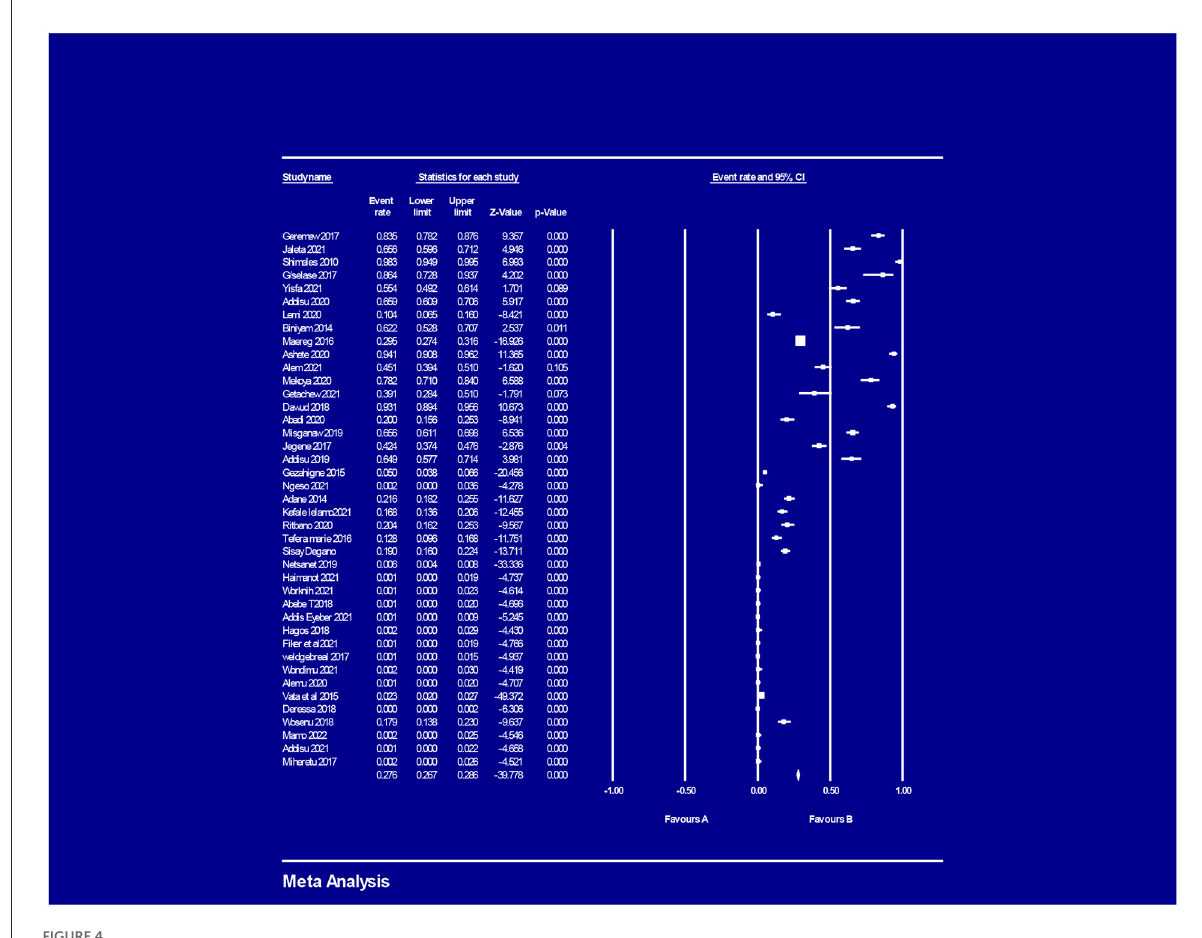
FIGURE4 The pooled analysis of the risk of adverse maternal